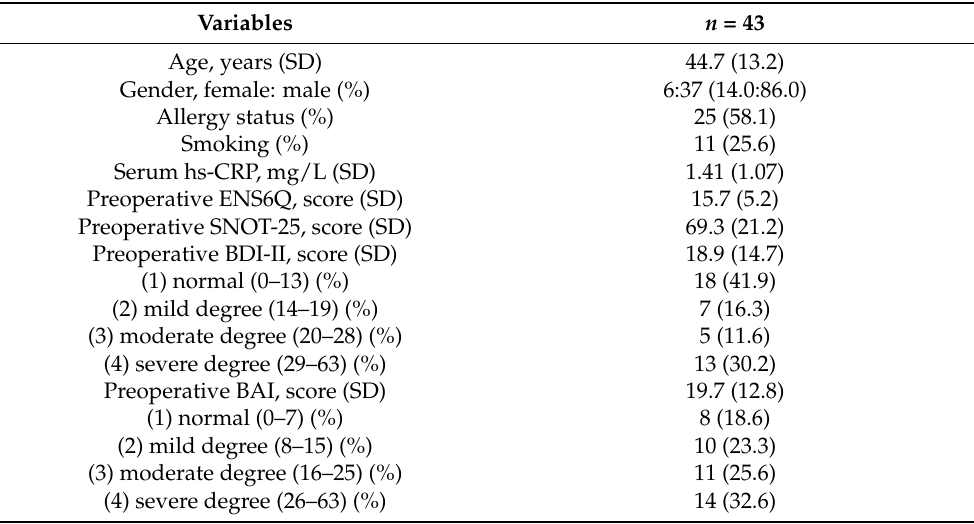
Table 1. Demographic data, laboratory parameters, and pre- and postoperative subjective assess- ments in our study subjects.